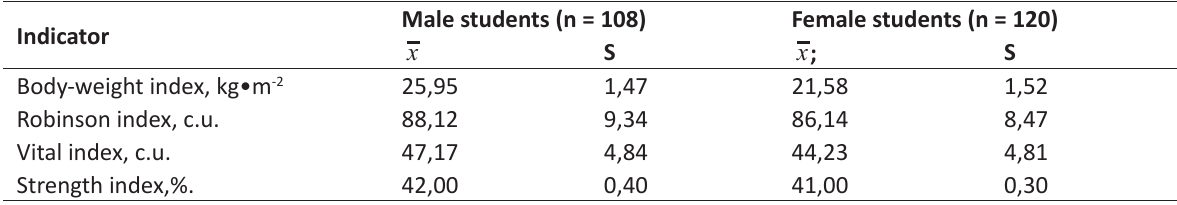
Table 1. Evaluation of indicators of students’ physical